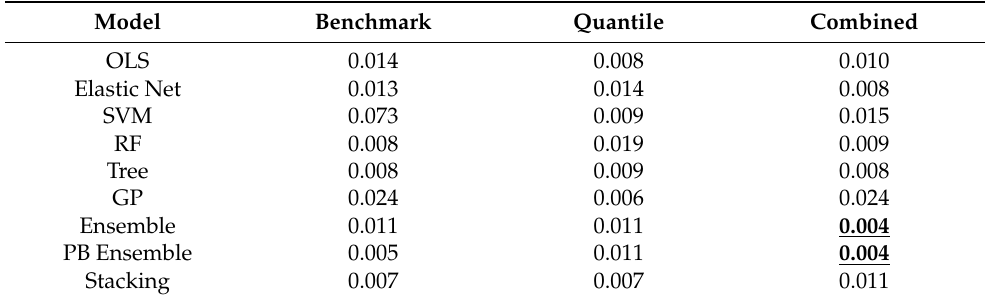
Table 2. Predictive accuracy for hourly aggregations-mae–lowest error underlined in bold.